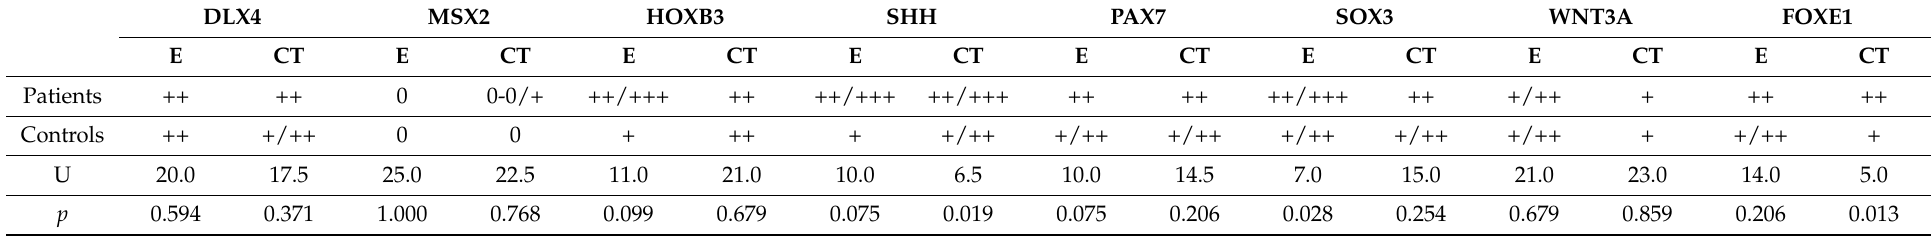
Table 2. Semiquantitative evaluation of immunoreactivity of DLX4, MSX2, HOXB3, SHH, PAX7, SOX3, WNT3A and FOXE1 in patient and control